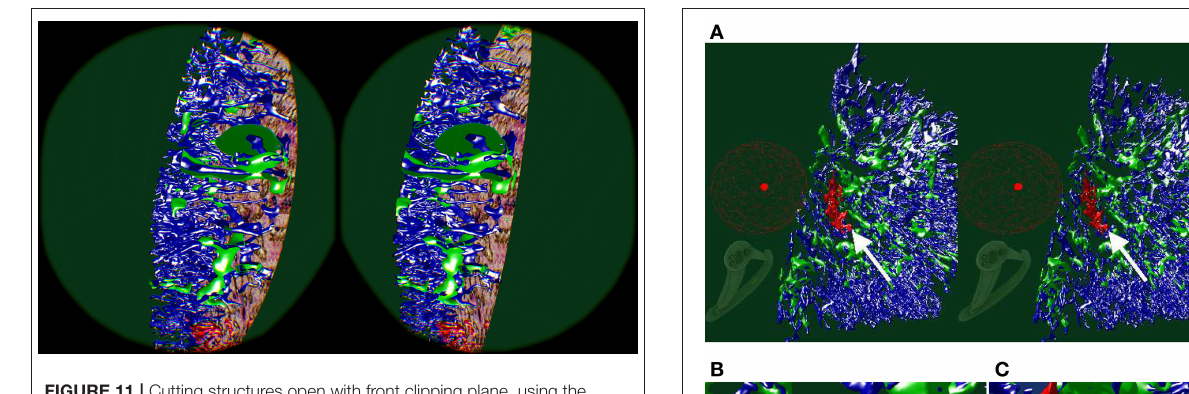
FIGURE 11 | Cutting structures open with front clipping plane, using the “sinus” data set. Capillaries are blue, capillary sheaths are green in the reconstruction. An original section is visible on the right.